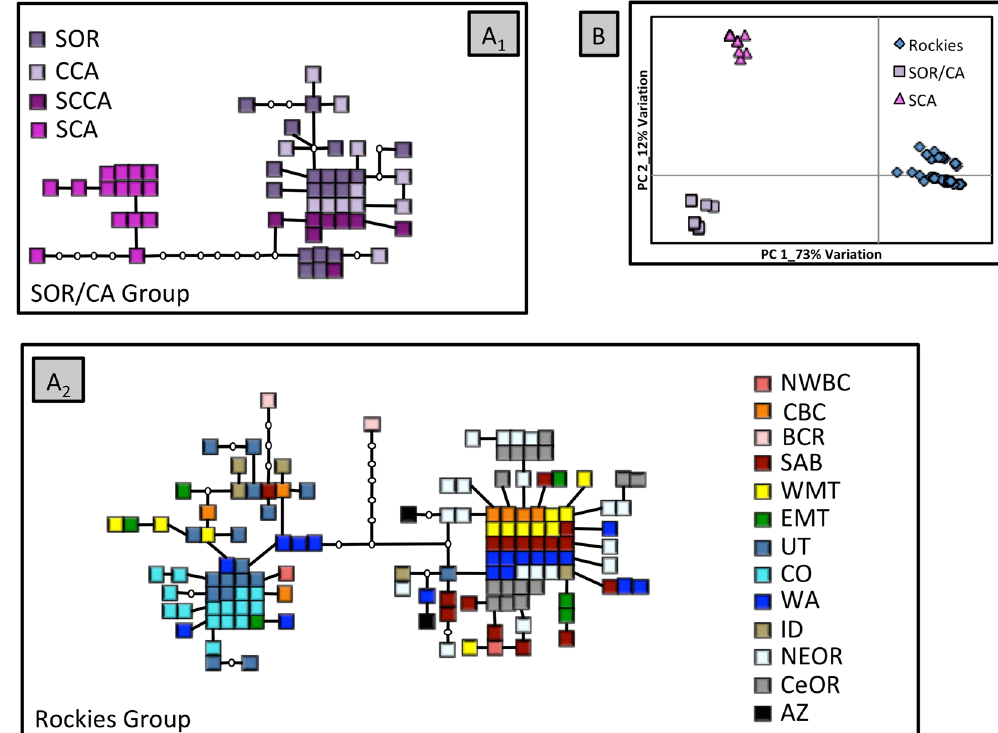
Figure 2. ( A ) Statistical parsimony network of mtDNA haplotypes for mountain chickadees: A 1 SOR/ CA group; A 2 Rockies group. Each square represents a single individual and open circles indicate inferred haplotypes. Refer to Fig. 1 for location of sampling sites. ( B ) Principal coordinate analysis of mtDNA data based on population location. Coordinate 1 explains 73% of the variation and coordinate 2 12%.